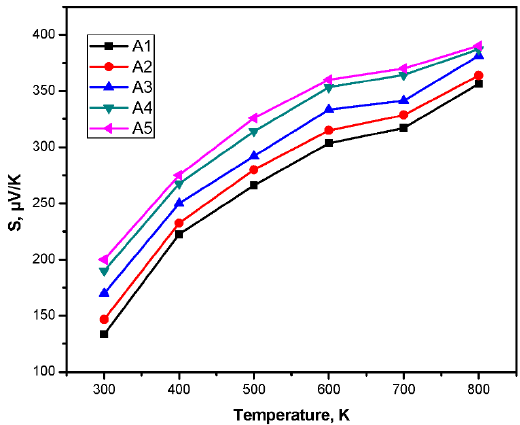
Figure 10. Plot of thermo-electromotive force versus temperature difference from two points on the pellets. the